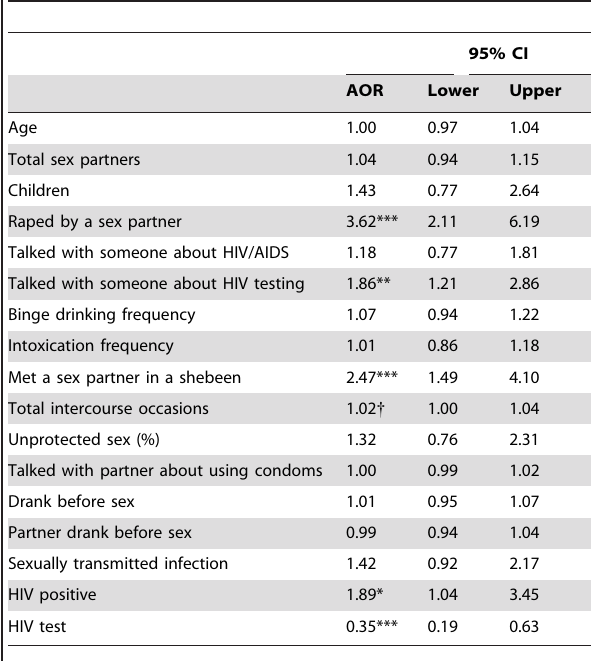
Table 4. Multivariate model for fear of negotiating condom use among women ( n